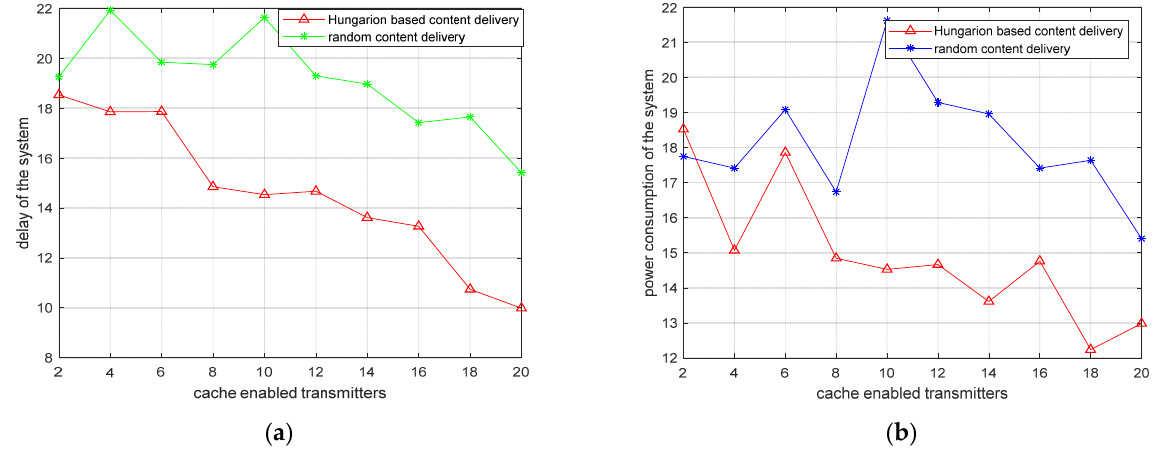
Figure 10. ( a ) Performance comparison of the delay of the system; ( b ) Performance comparison of the power consumption of the system.